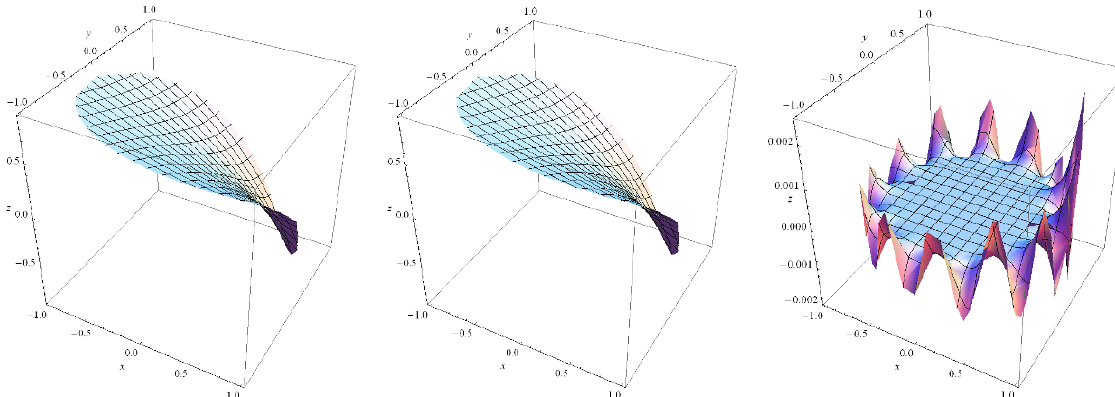
Figure 5. Second example, n = 12 : function u , interpolant p , error u − p